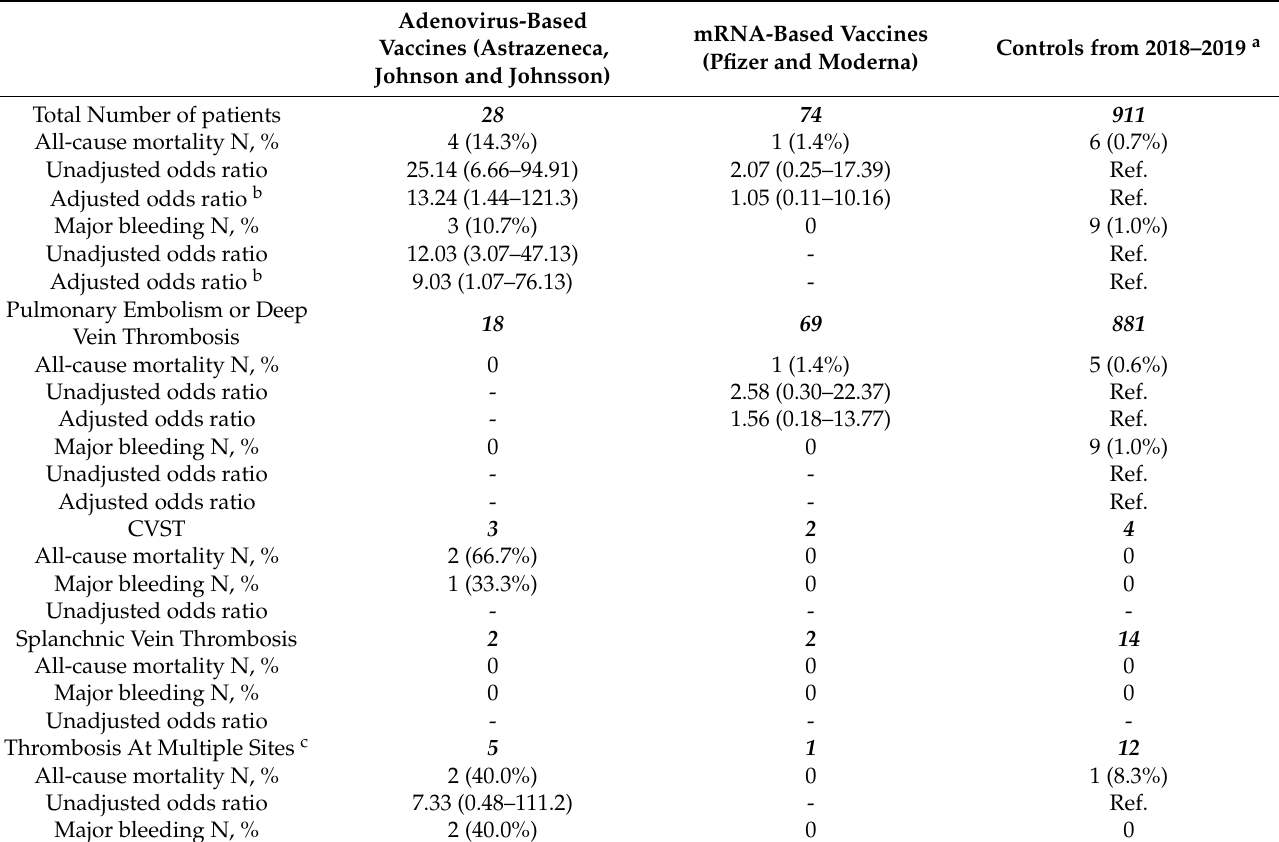
Table 3. Clinical